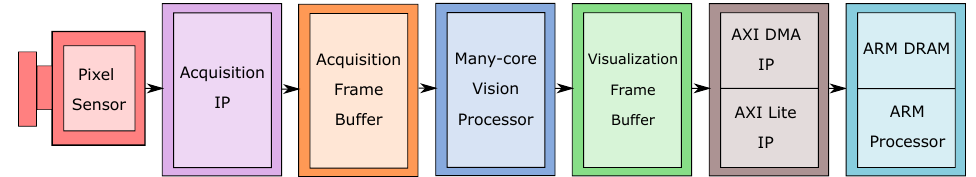
Figure 2. Block diagram of the complete Smart Camera